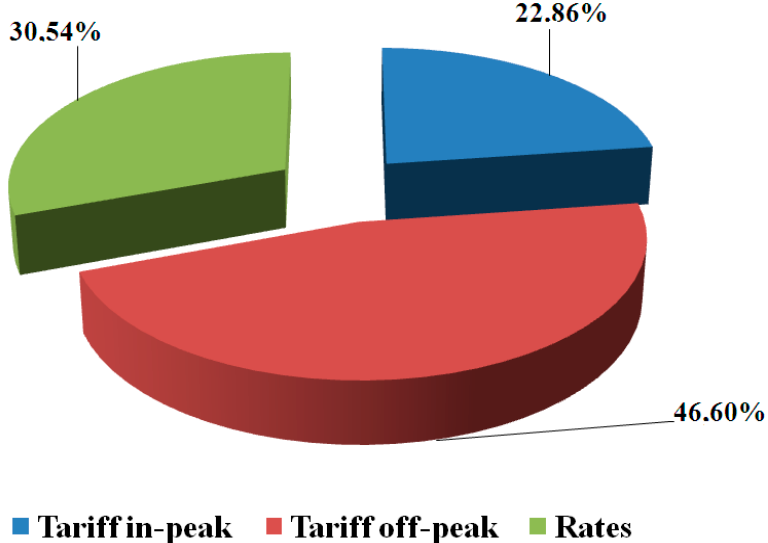
Figure 8. Tariff influences on the cost of a smart grid project that combines the White Tariff with a photovoltaic system (Horosazonal photovoltaic system (Horosazonal software).